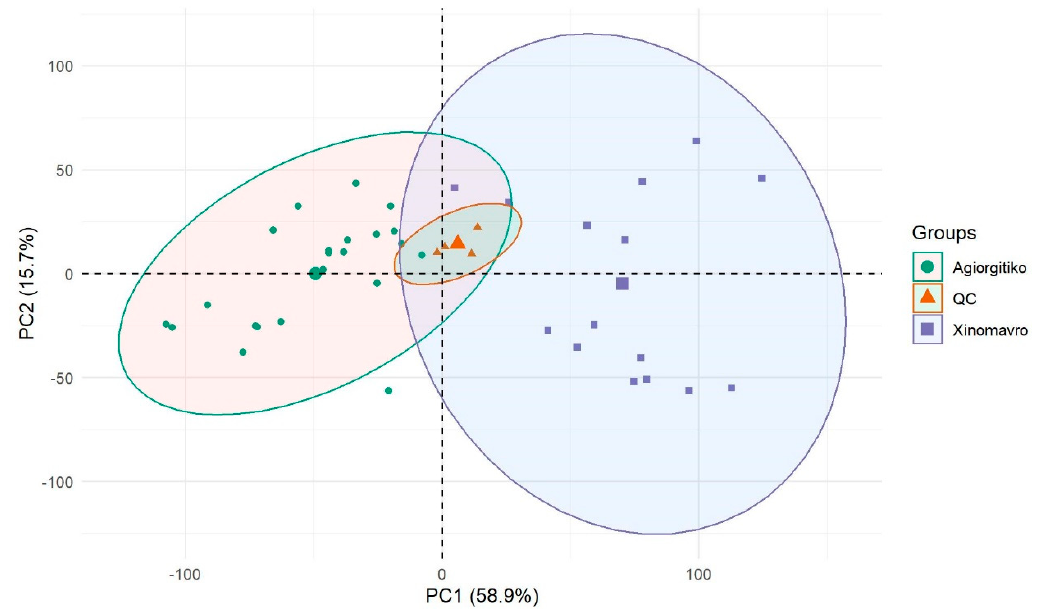
Figure 3. Principal Components Analysis (PCA) score plot showing the unsupervised clustering of red wine samples and QC distribution.